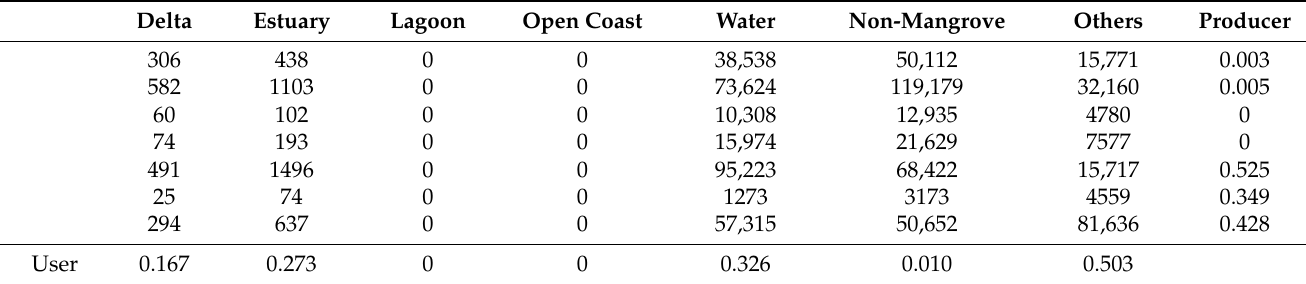
Table 8. Confusion matrices with relative user and producer accuracies produced using U-Net for the 2018 classified image.